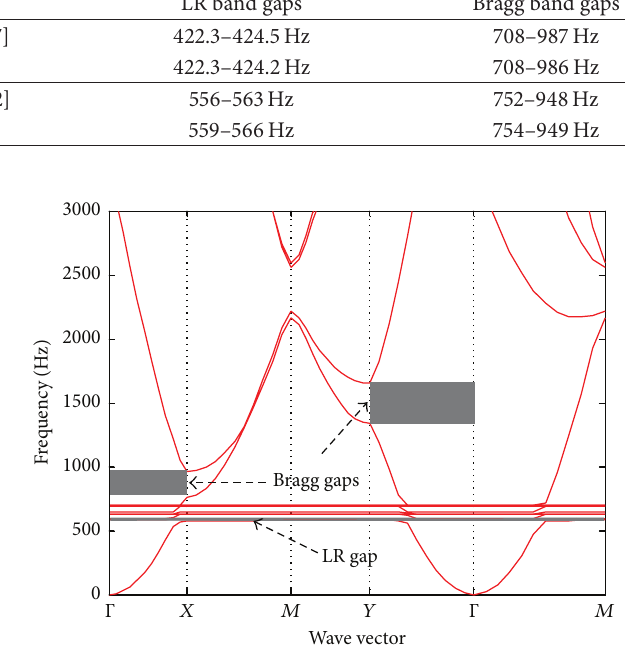
Figure 4: Band structure of the two-dimensional PPC-C of tetrag- onal lattice, where 𝑎 = 80 mm and 𝐿 = 0.2 H.